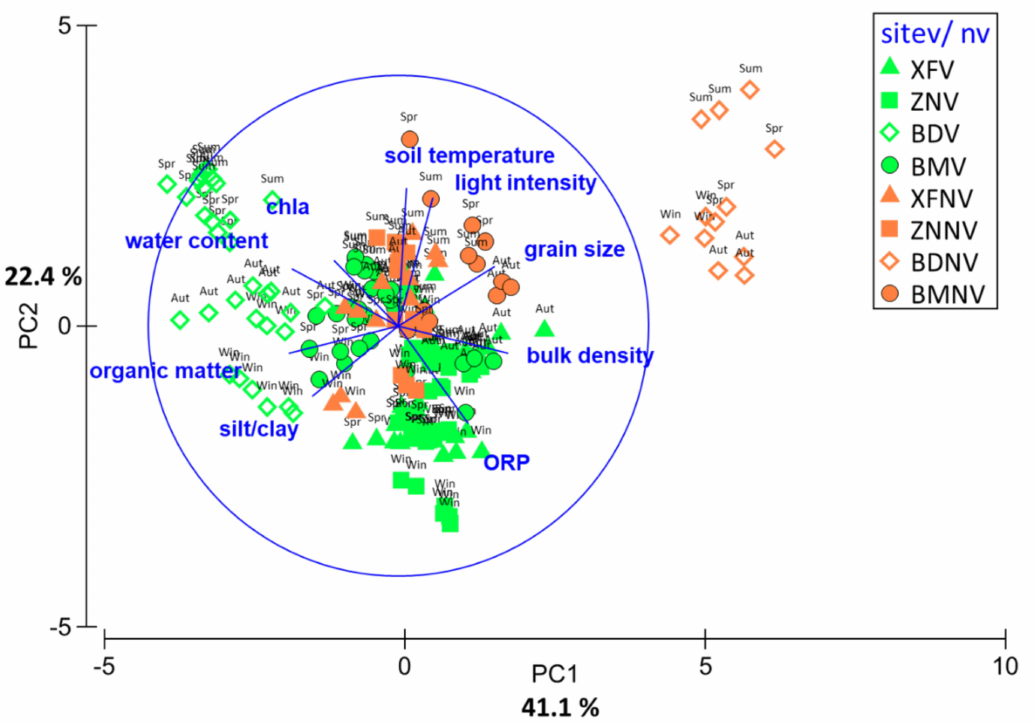
Figure 4. PCA of the sediment features in mangroves (V) and nonvegetated mudflats (NV) on the western coast of Taiwan in different seasons. Black: mangroves, gray: mudflats, (cid:78) : XF, (cid:4) : ZN, aut,